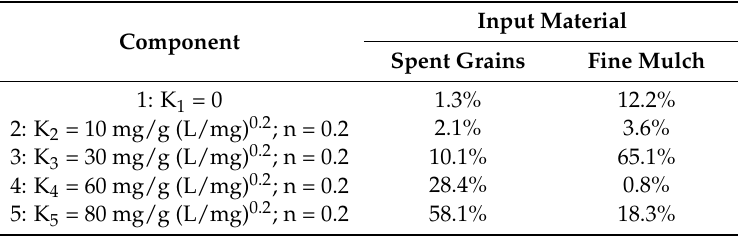
Table 3. Fractions of five fictive components derived from overall isotherms for pre-treated HTC process water (K 1 –K 5 and n are the Freundlich isotherm parameters of each component). Component Input Material